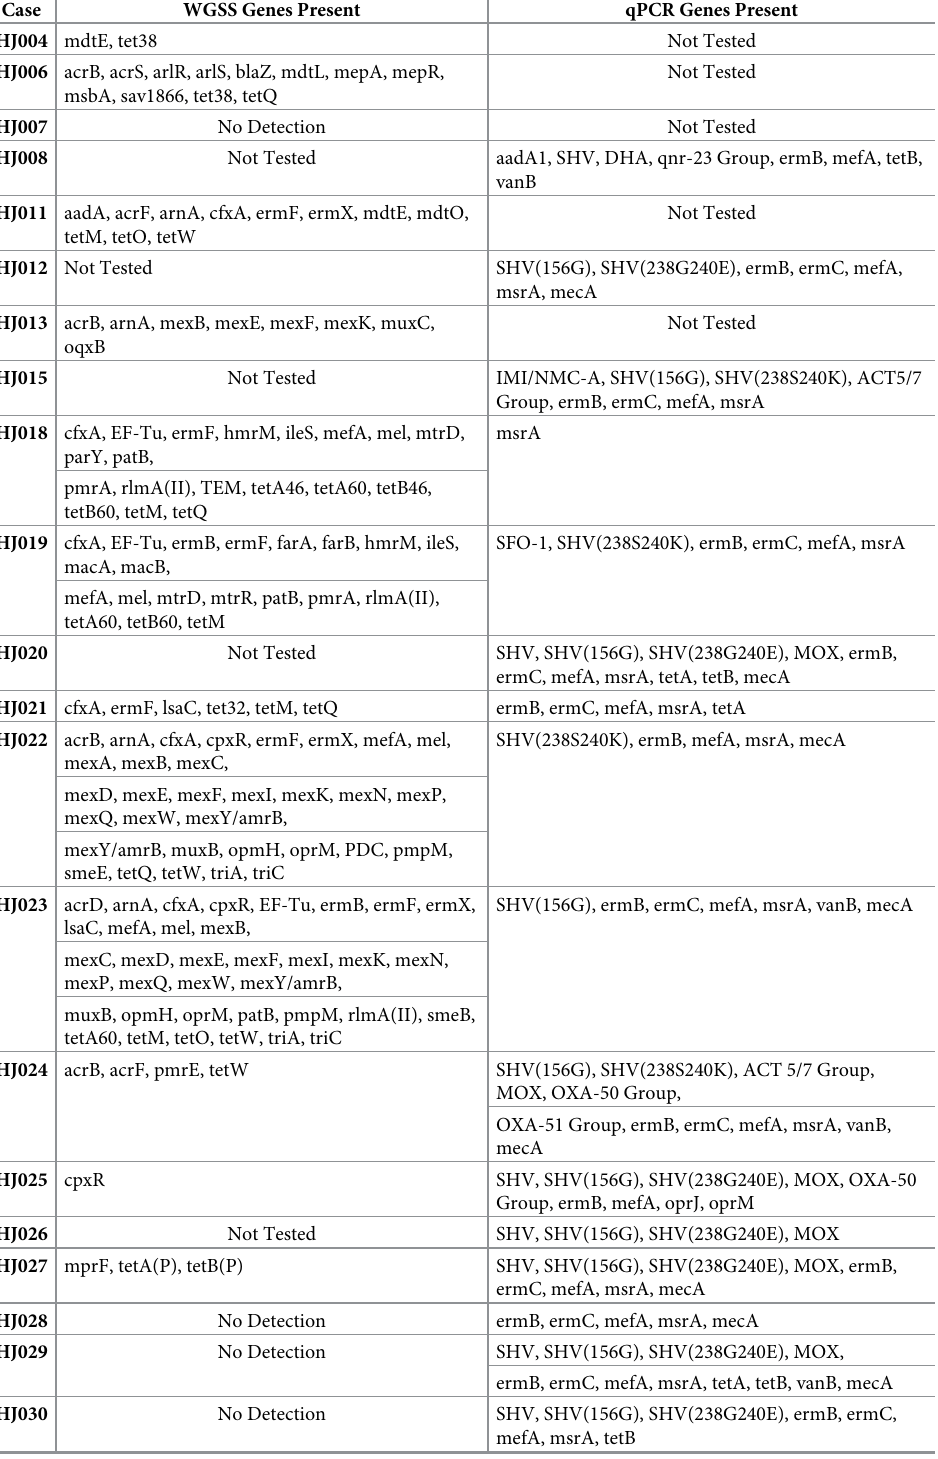
Table 1. Table showing identified ARGs among cases using whole genome shotgun sequencing (WGSS) and qPCR